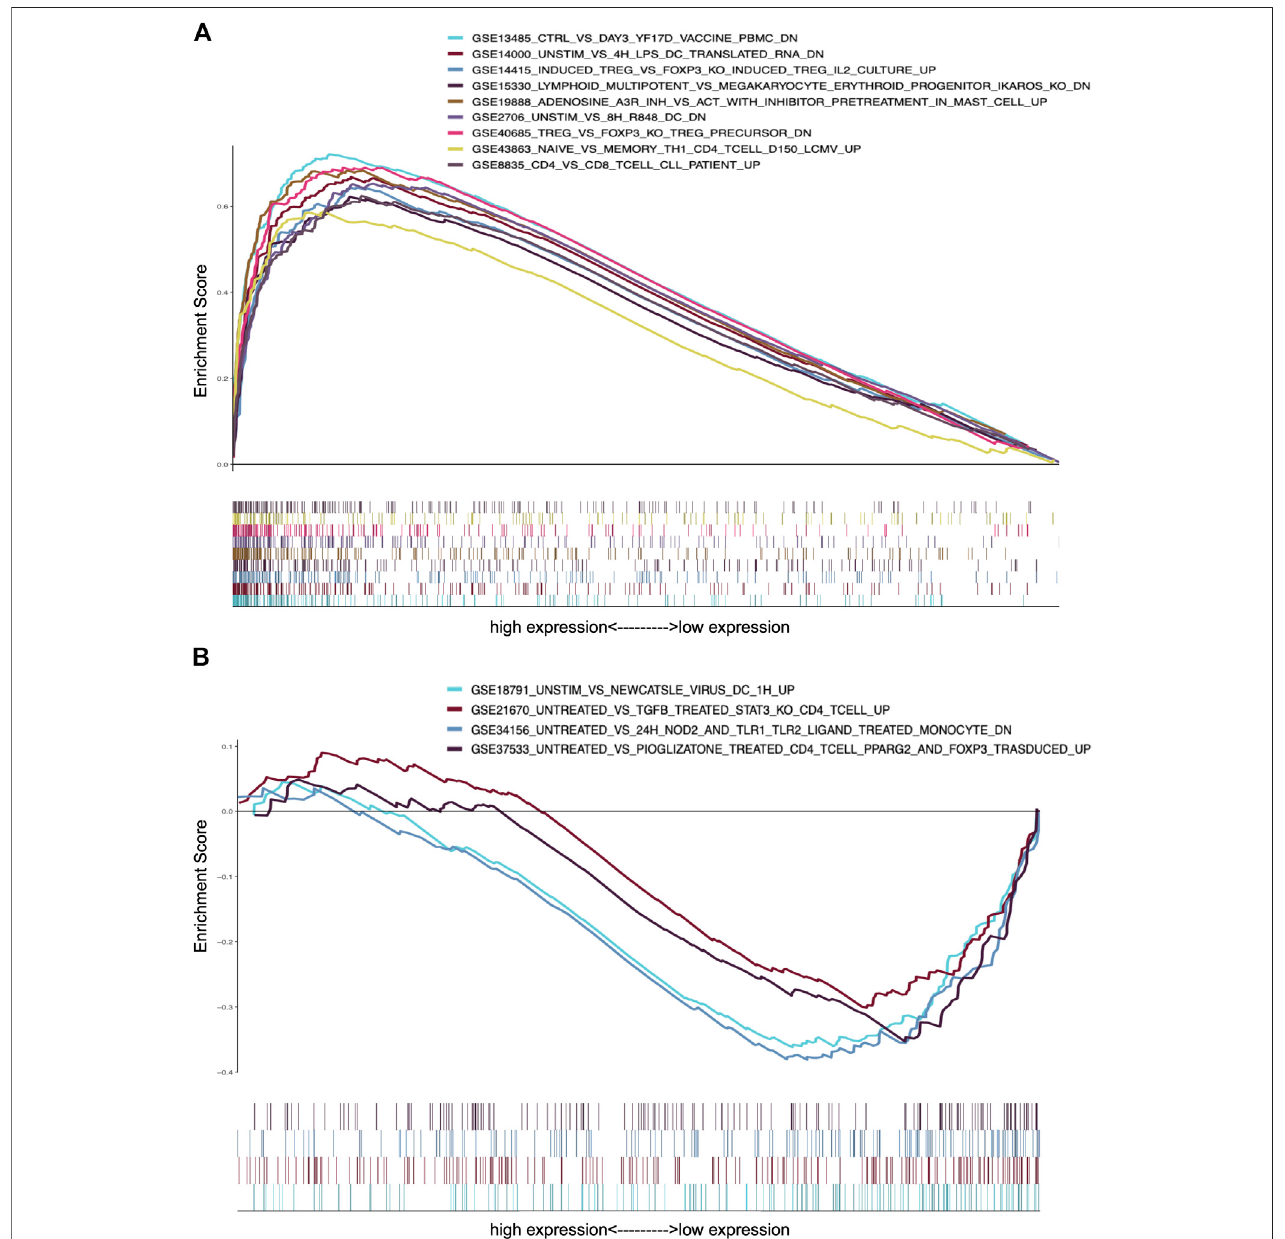
FIGURE 8 | GSEA analysis of CXCL10 expression in PAAD. (A) The enriched gene sets in C7 collection by the high CXCL10 expression cases. (B) The enriched gene sets in C7 collection by the low CXCL10 expression cases. Each color represented corresponding gene set. Genes on the right of X-axis had positive correlation with gene sets, while genes on the left of X-axis had negative correlation with gene sets. Only gene sets with NOM p value < 0.05 were considered as statistically signi fi cant.